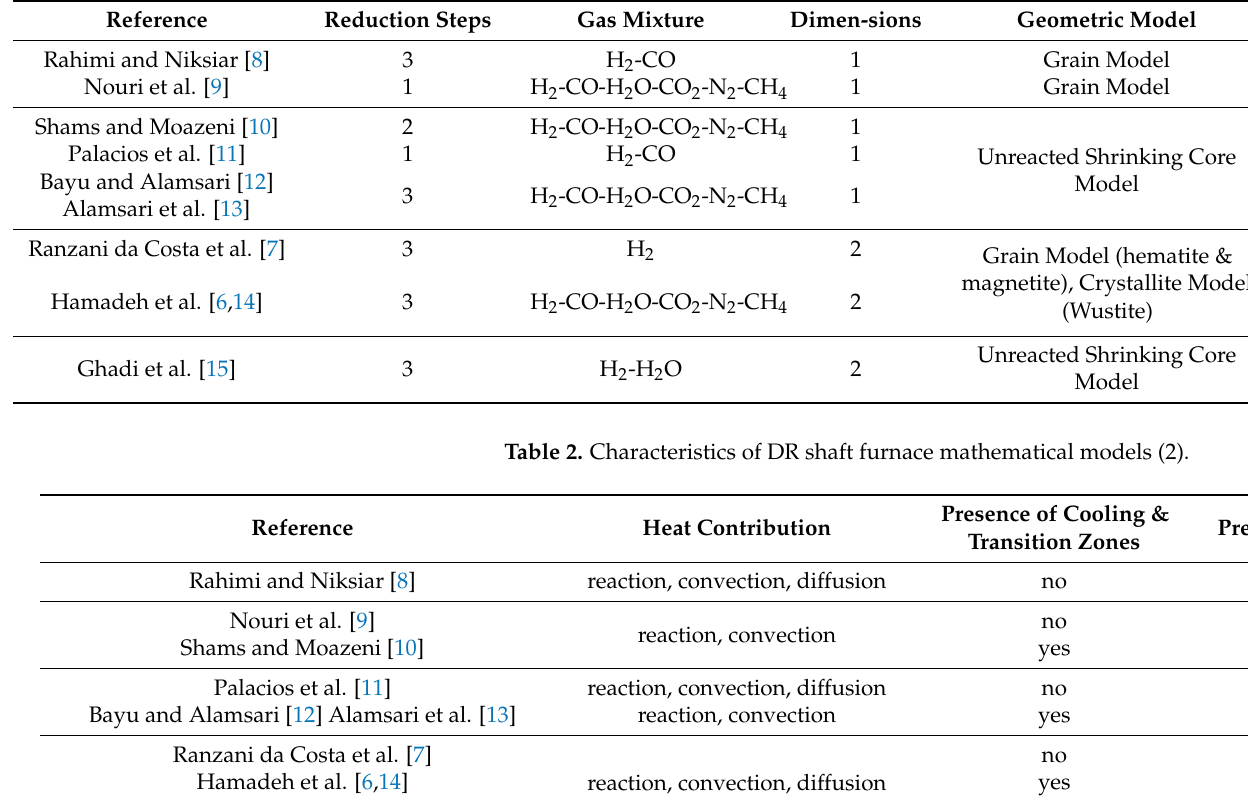
Table 1. Characteristics of DR shaft furnace mathematical models (1).